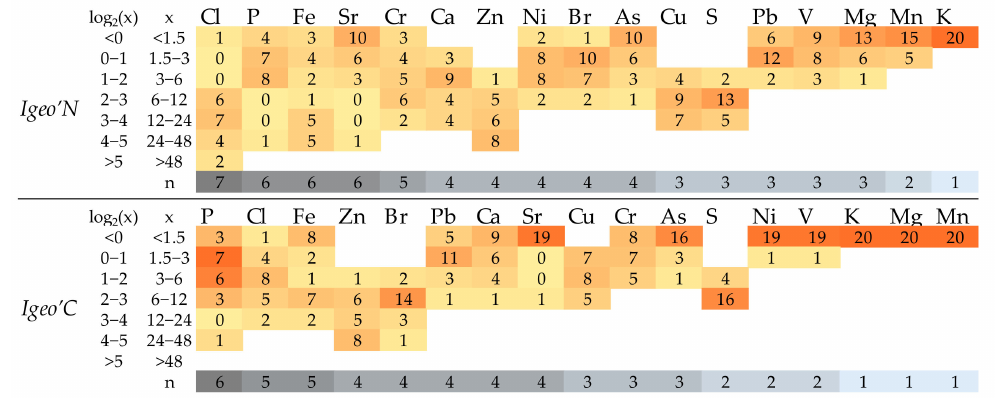
Figure 14. The frequency distribution of elemental Igeo’N and Igeo’C values of twenty TSP sam- pling sites in seven so-called contamination classes SCC . Explanation: log2(x) column indicates the threshold values of SCC intervals for logarithmic data, while x column shows respective values for non-logarithmic data. n is the total number of SCC , in which the scatter of occurrences was